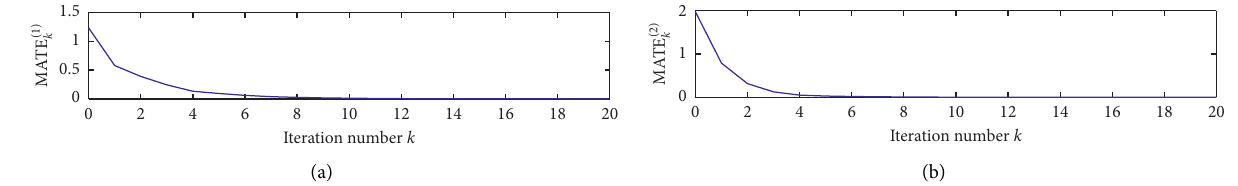
Figure 4: Tracking error indexes MATE ( 1 )